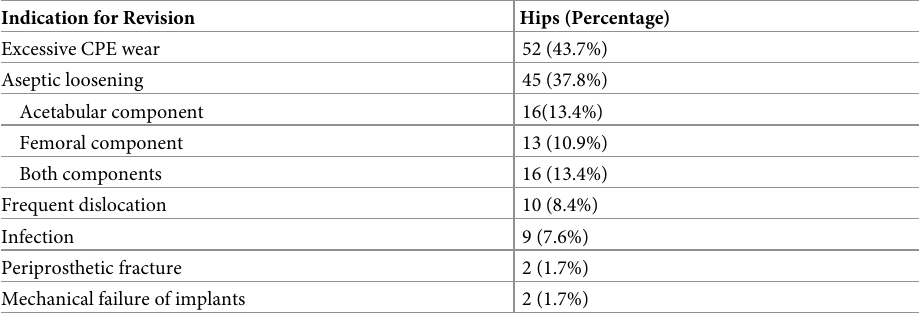
Table 2. Indications for revision.